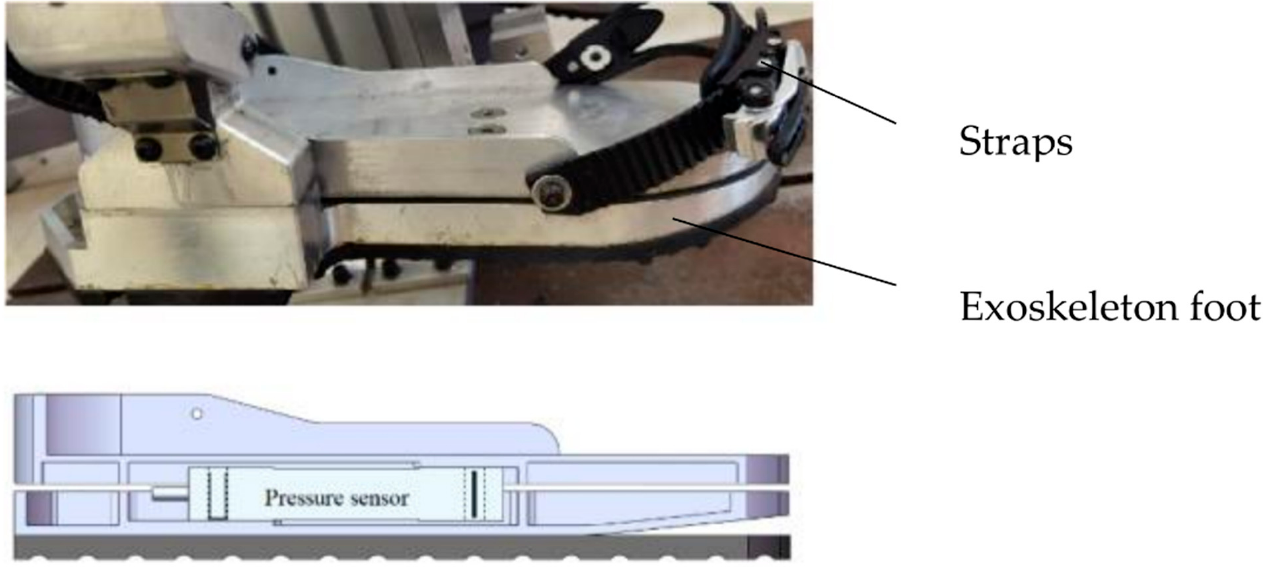
Figure 10. Exoskeleton foot and its sectional view.